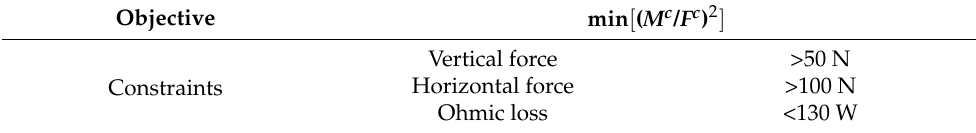
Table 4. Objective and constraints of optimization for the 3-phase coil set of the planar